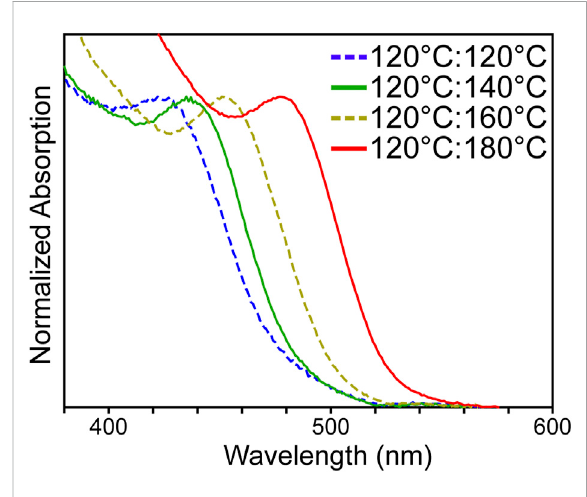
FIGURE 4 CdSe QD absorption spectra with and without (NMe 4 ) 4 [Zn 10 Se 4 (SPh) 16 ] cluster seeds. The single-stage reactor temperature was set to 150 ° C.